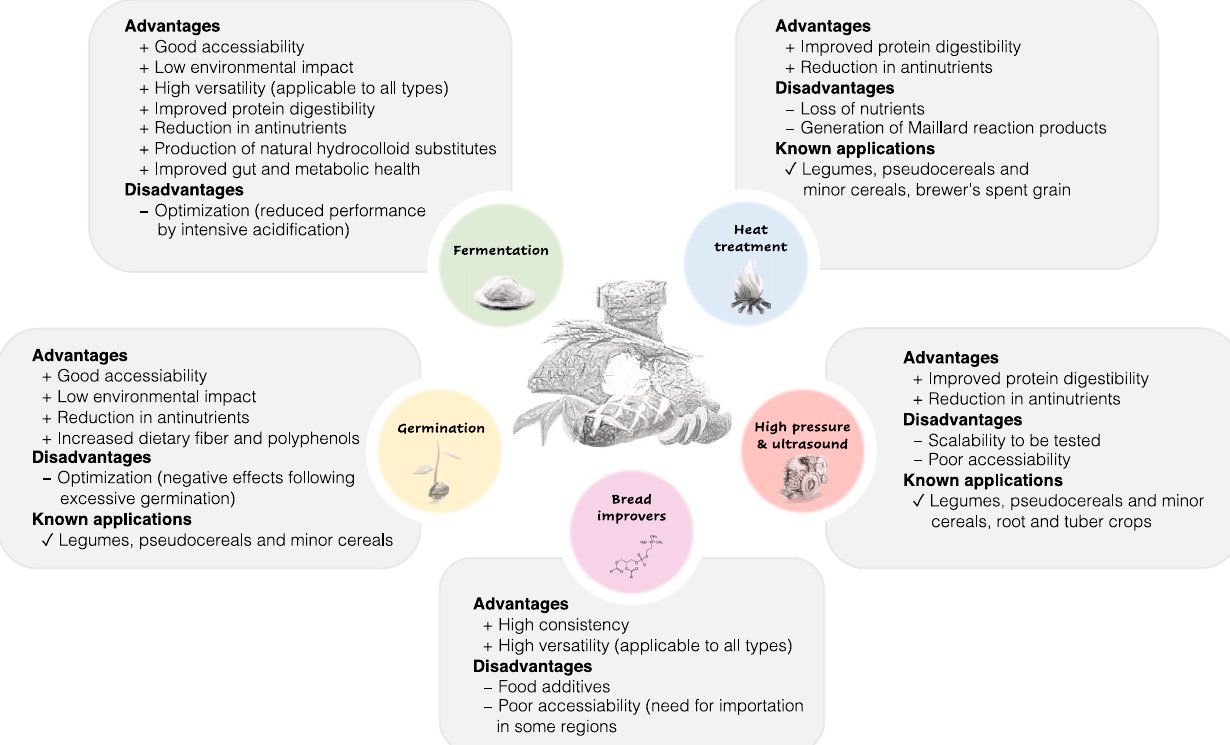
Fig. 4 Summary of important processing strategies for improving sensory and nutritional quality of composite